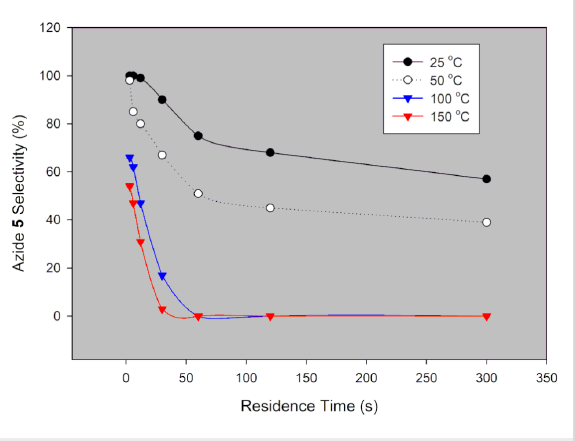
Figure 14: Continuous-flow system for C-3 azidation of mesyl shiki- mate using